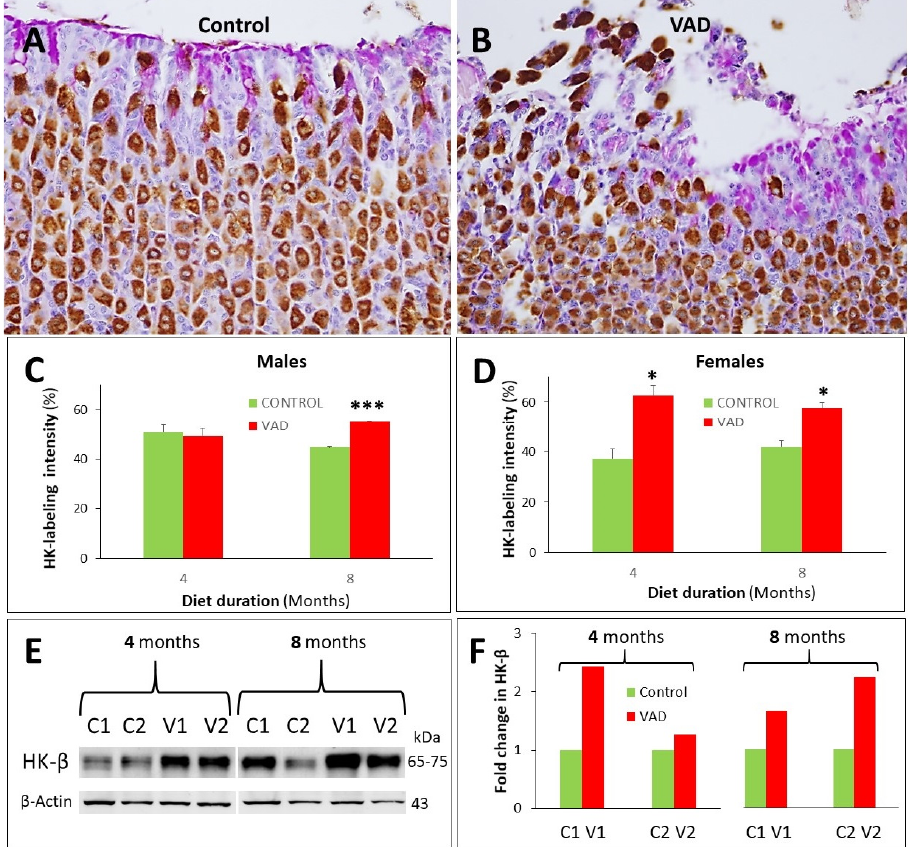
Figure 9. Immuno-analysis of H + , K + -ATPase in the gastric mucosae of control and VAD mice. Probing of 8-month control ( A ) and VAD ( B ) male stomach tissues shows brownish parietal cells expressing H + ,K + -ATPase and scattered along the gastric glands ( A , B ). Quantification demonstrates increased parietal cell labeling intensity in VAD tissues ( C , D ). Western blotting using gastric mucosal homogenates from two pairs of control and VAD 4- and 8-month mice shows upregulation of H + ,K + - ATPase ( E , F ). Representative individual ImageJ data are normalized using β -actin and presented as fold change relative to the control. Scale bars = 100 µ m. * p < 0.05, and *** p <